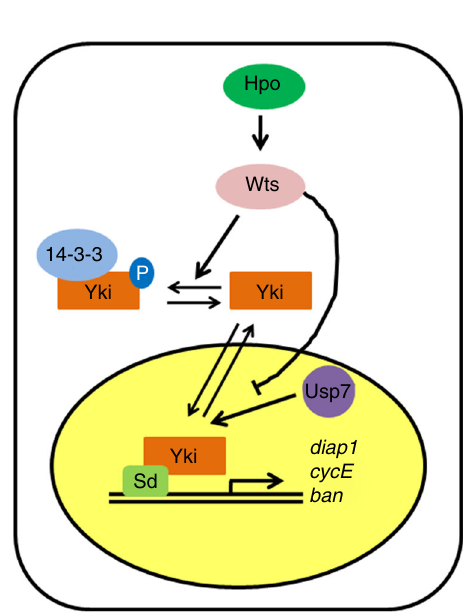
Fig. 8 A proposed model of Usp7 deubiquitinating Yorkie (Yki). When Hippo (Hpo) pathway turns on, Hpo phosphorylates and activates Wts. In turn, Wts phosphorylates the transcriptional coactivator Yki, culminating Yki retention in the cytoplasm via binding with 14-3-3. When Hpo pathway is closed, Yki translocates into the nucleus to activate the target gene expression with the assistance of Sd. The nuclear Yki protein is destabilized by proteasome, which is attenuated by